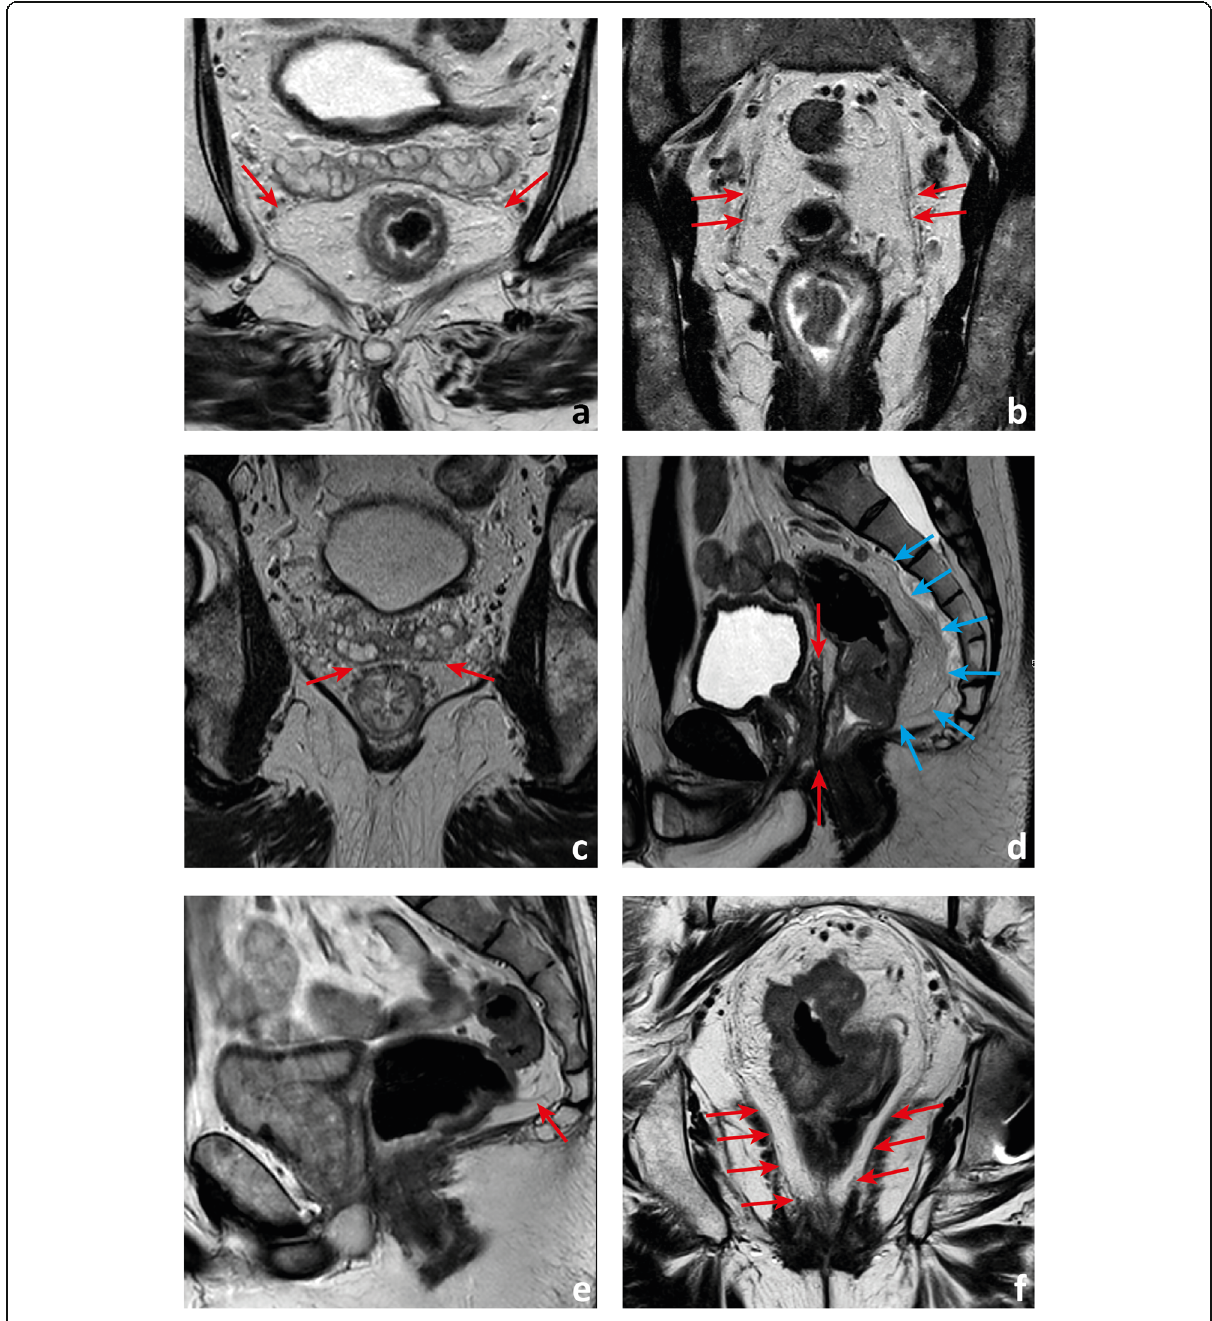
Fig. 5 The mesorectal fascia may present with gaps, particularly anterolaterally (arrows in a ). It is a multilayered envelope and as such multiple hypointense lines may be apparent (arrows in b ). Anteriorly, in between the neurovascular bundles, extending from the peritoneal reflection down to the pelvic floor, the mesorectal fascia is juxtaposed to the Dennonvillier fascia (between red arrows in c and d ). Posteriorly, it is juxtaposed to the presacral fascia (blue arrows in d ). Sometimes, the presacral compartment is divided by the Waldeyers fascia (arrow in e ) into superior and inferior compartments. Inferiorly, the mesorectal fascia tappers and is “ lost ” within the intersphincteric plane (arrows in f